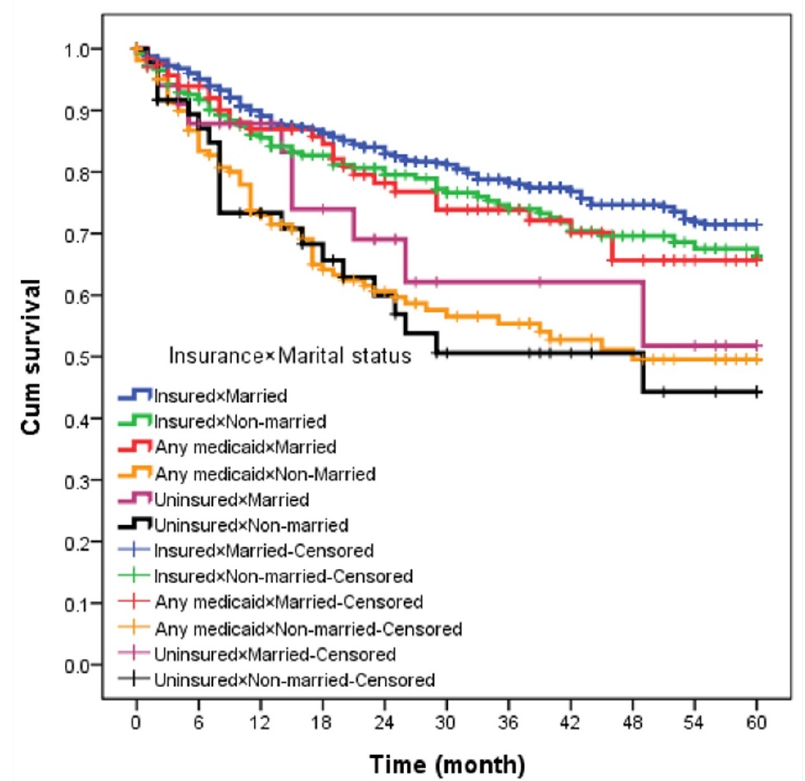
Figure 1. The 5-year overall survival according to insurance × marital status. Table 2. Univariate analysis for 5-year overall